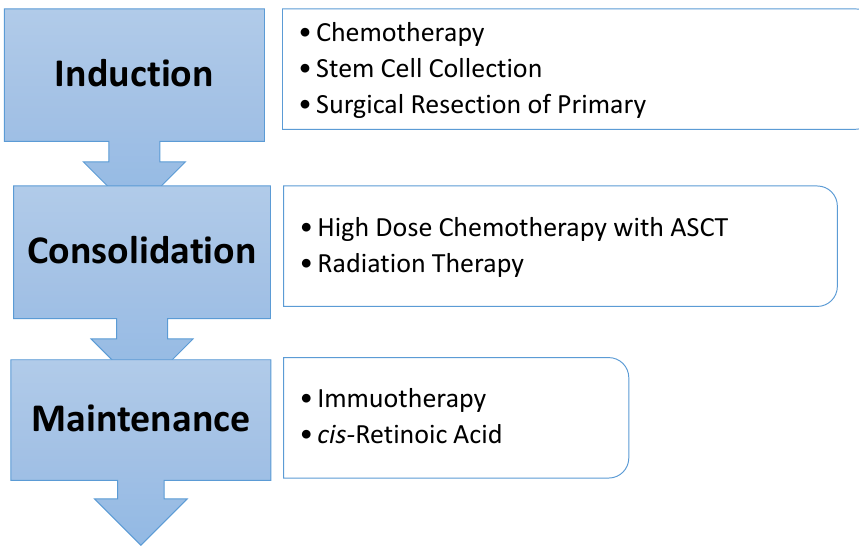
Figure 1. High-risk neuroblastoma treatment overview.